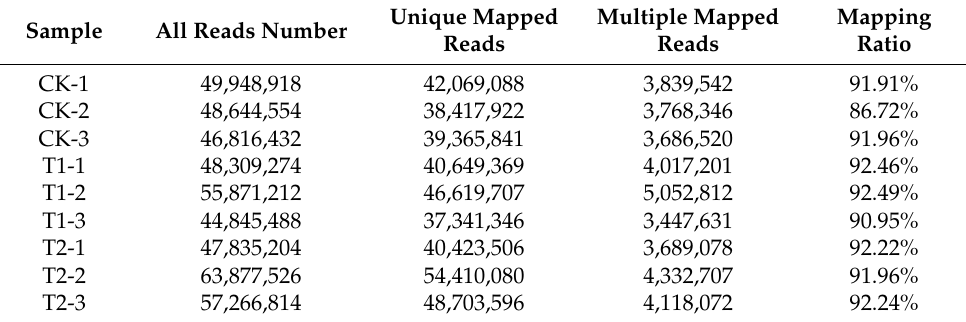
Table 5. Statistical results of 9 samples compared with reference